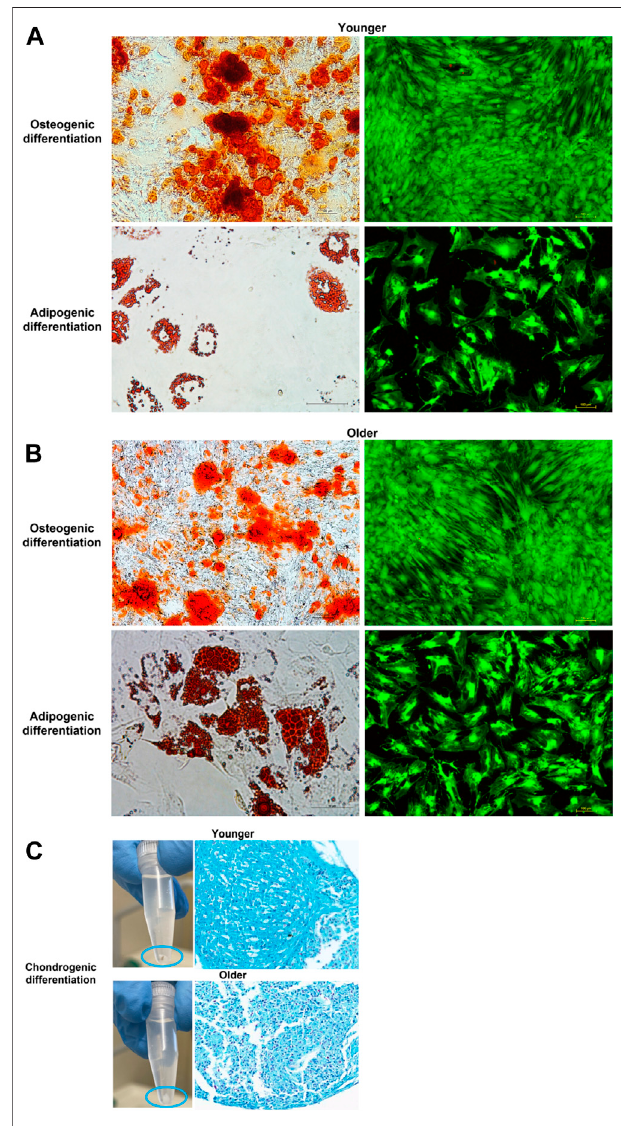
FIGURE 8 | (A) Representative images of osteogenic and adipogenic differentiation of MSCs derived from clotted BMAs from younger donors (left: Alizarin Red S staining, magni fi cation × 10, and Oil red O, magni fi cation × 20; right: LIVE/DEAD fl uorescent staining, magni fi cation × 10), (B) from older donors (left: Alizarin Red S staining, magni fi cation × 10 and, Oil red O, magni fi cation × 20; right: LIVE/DEAD fl uorescent staining, magni fi cation × 10), and (C) images of chondrogenic differentiation from both younger and older donors(Alcianblue – nuclearfastredstaining,magni fi cation × 10)